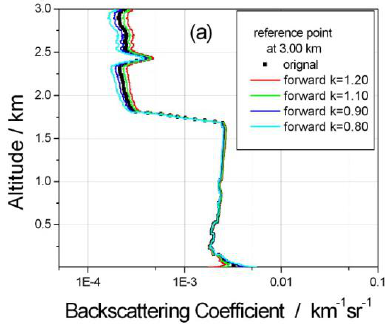
Fig. 2 Retrieval of the aerosol backscattering coefficient profiles using the backward integral As to the backward integral, the reference point is selected at 3.00 km altitude, the original values of the aerosol backscattering coefficient at the reference point are 0.00024 km -1 sr -1 in Fig.